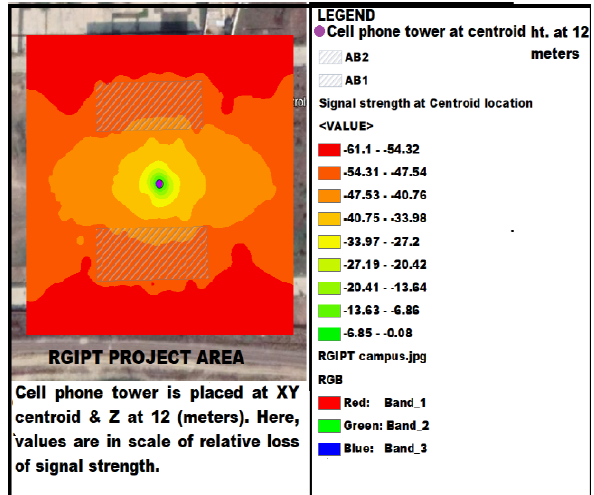
Figure 17. Cell phone tower at XY Centroid and Z at 12 meters